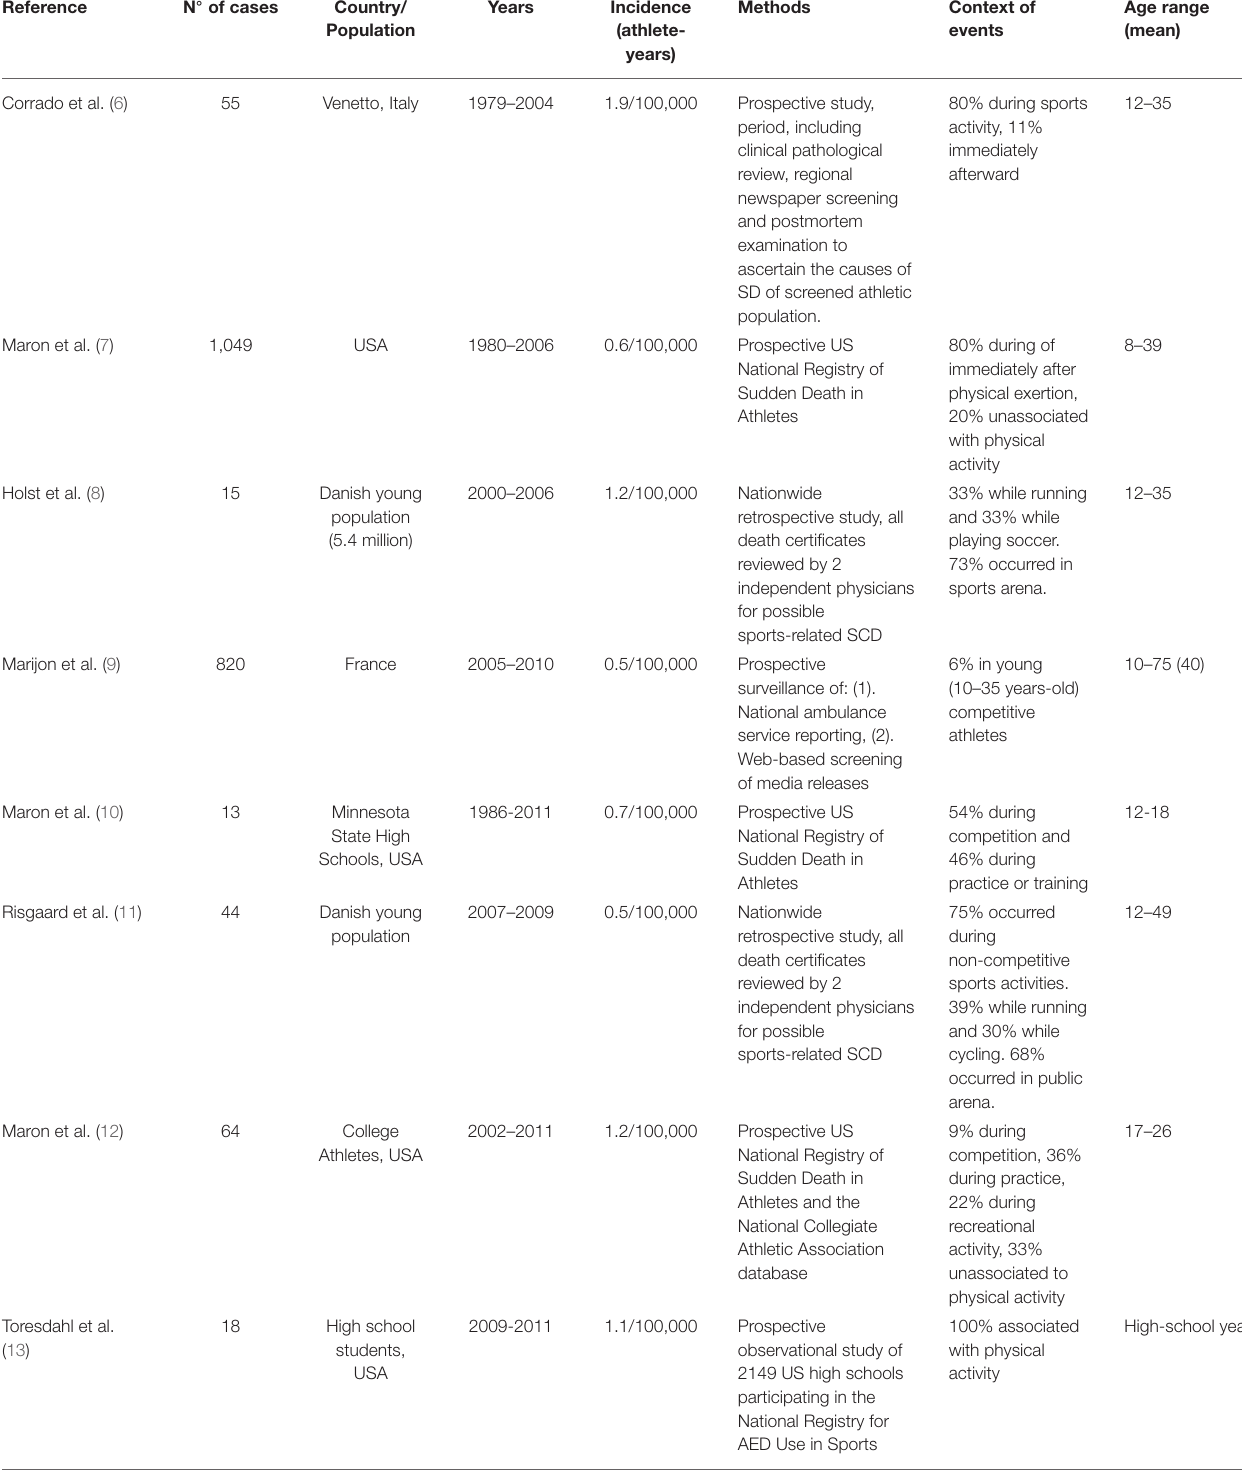
TABLE 1 | Incidence of sports-related sudden cardiac